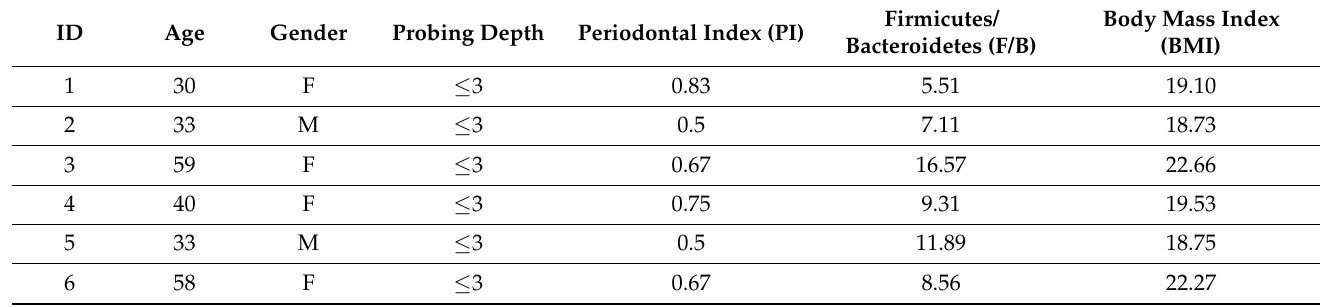
Table 1. Demographic and Clinical Information.